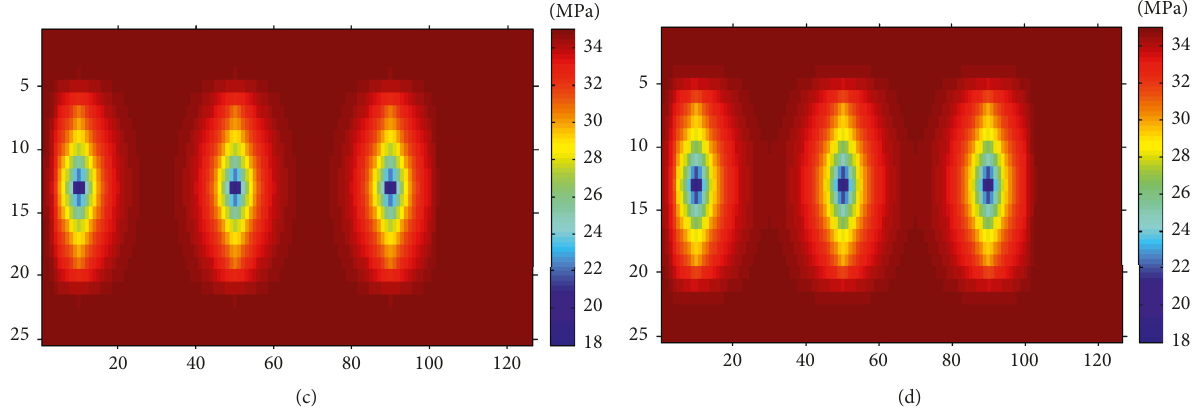
Figure 14: Distribution of shale matrix pressure: (a) t